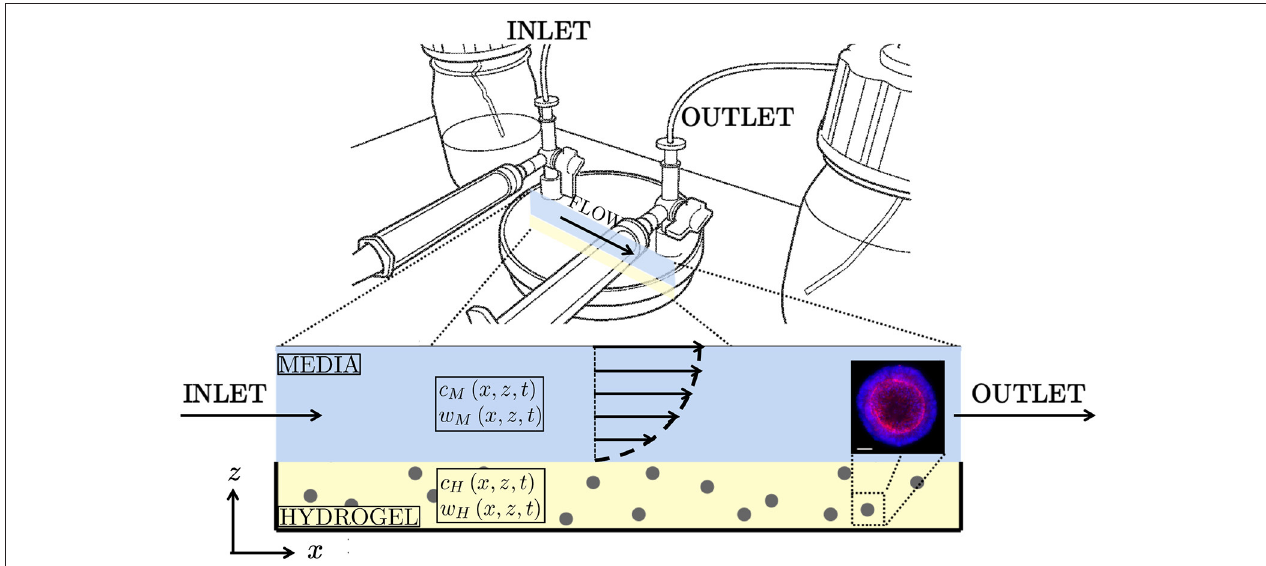
FIGURE 1 | (Top) Schematic of “CXP1” bioreactor (Ellis et al., 2019). (Bottom) Two-dimensional cross-section of the bioreactor, with arrows indicating the half-Poiseuille flow profile. Blue is media, yellow is hydrogel, grey is organoid biomass. The glucose concentrations within the media and hydrogel are given by c M and c H , respectively. Similarly, the lactate concentrations within hydrogel and media are denoted w M and w H , respectively. (Bottom right) Example of colorectal cancer organoid. Confocal image using 20X objective of Cell Insight Cx7. Organoid stained for nuclear (blue) and cytoskeletal (red) markers for imaging. Scalebar 50 µ m. Reproduced with permission from